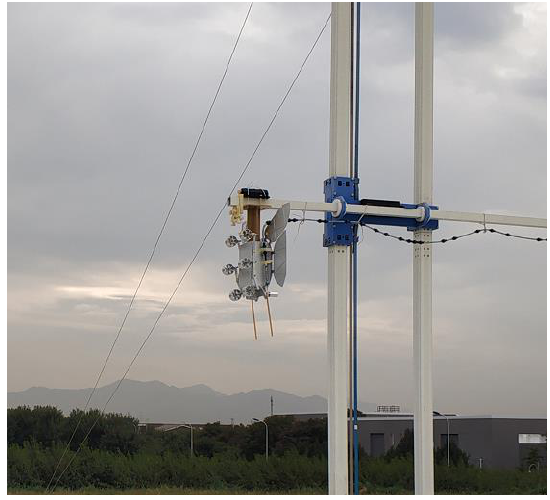
Figure 9. Gain test state of the scaled model.